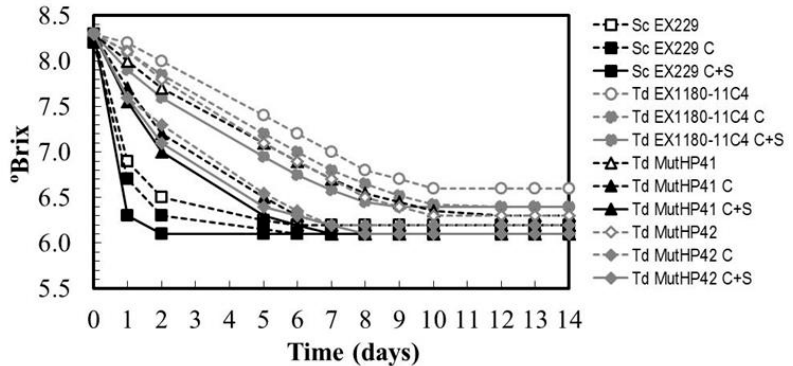
Figure 8. Fermentation kinetics of some T. delbrueckii HP R mutants inoculated in synthetic base wine supplemented with 30 mg/L SO 2 . Before inoculation, the yeast cultures were unconditioned (no indication following the name of the strain), conditioned with occasional shaking (C), or conditioned with continuous shaking (C+S). Data are the mean values of three fermentations inoculated with each yeast strain. Standard deviations were less than 9% of the means. The degree of dominance throughout fermentation of each inoculated yeast strain was 100%.